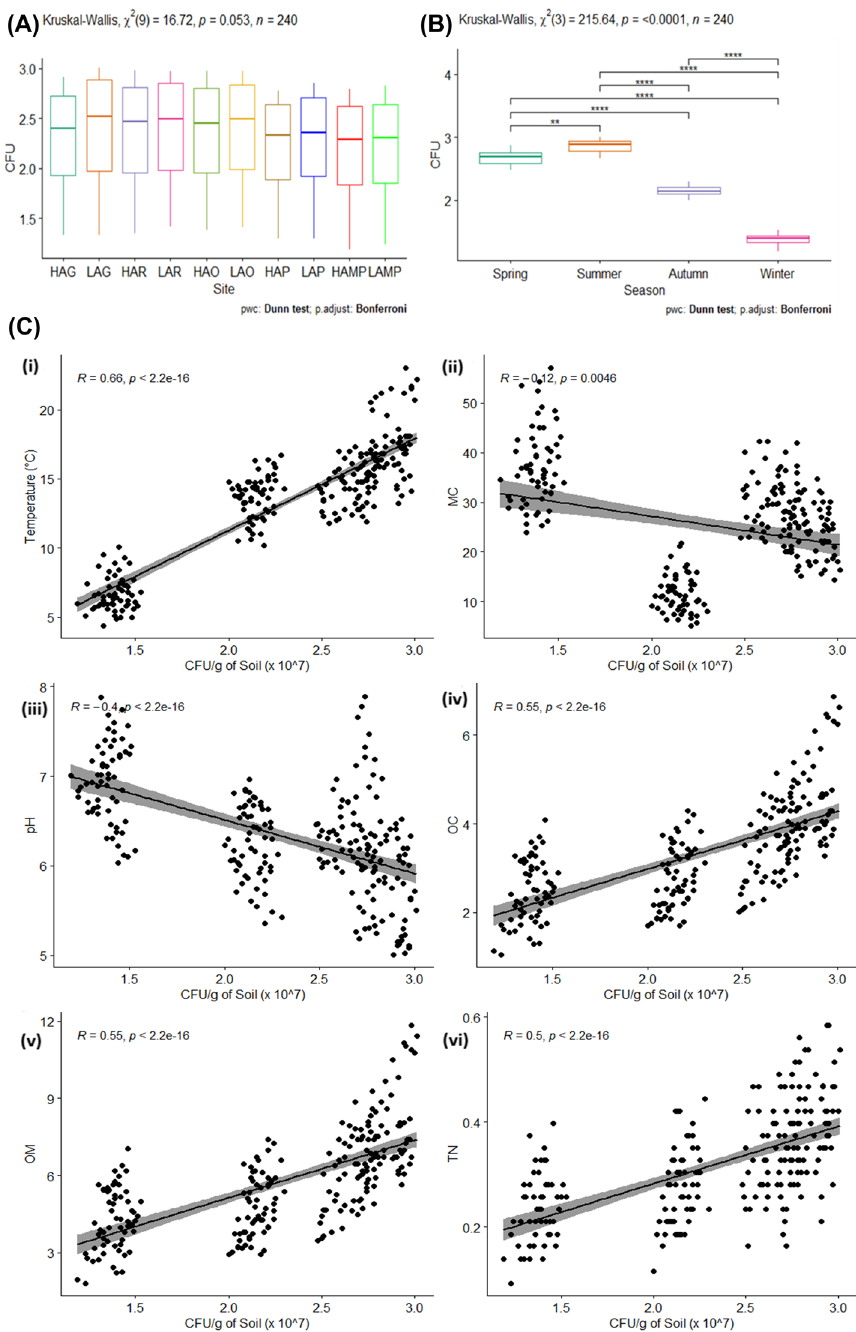
Figure 4. Site-wise ( A ) and seasonal variations ( B ) in soil bacterial colony forming units (CFU) of lower DNP. ( C ) Correlation of bacterial colony forming units (CFU) with various physico-chemical properties of soil—( i ) temperature, ( ii ) moisture content, ( iii ) pH, ( iv ) organic carbon, ( v ) organic matter, and ( vi ) total nitrogen obtained from different micro-vegetational habitats of lower DNP. ( D ) Taxonomic classification of bacterial strains isolated from Dachigam National Park,